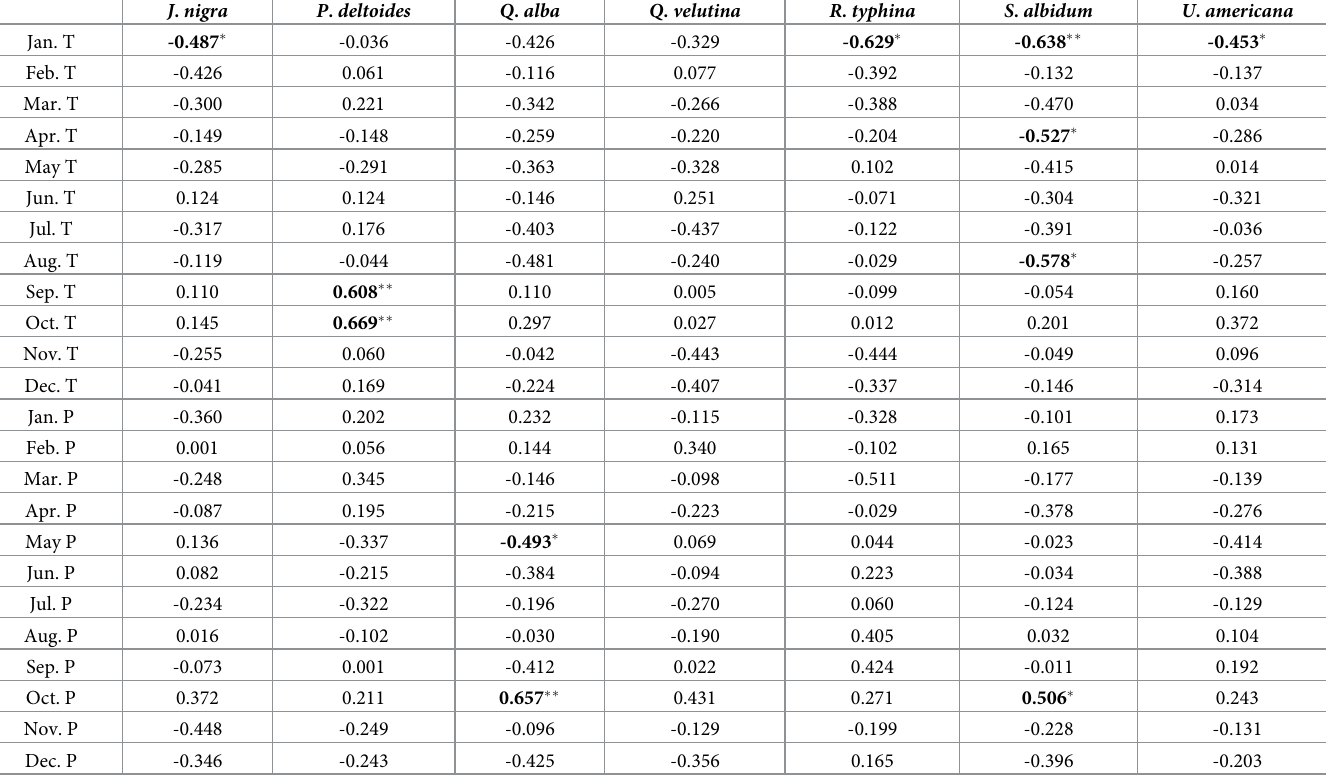
Table 3. Correlation coefficients for leaf fall DOY with mean monthly temperature (˚C) and total monthly precipitation (cm) for the month of and 11 months pre- ceding budburst in the seven focal